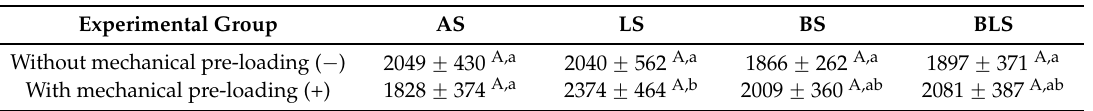
Table 2. Fracture loads (N) of all-ceramic crowns using different Ce-TZP/A framework designs (Mean ± S.D.)